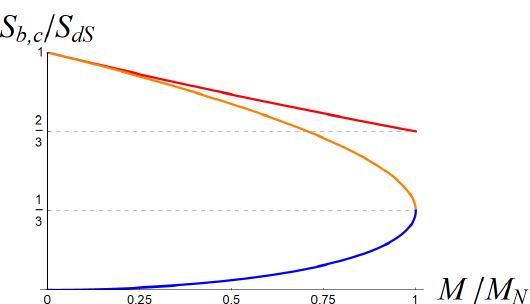
Figure 3: Horizon entropies S M / M , for d = 4. The blue curve corresponds to the black hole entropy S N orange curve shows the cosmological horizon entropy S S is approximately a straight line (red curve), and is always less than (or equal SdS to) S . For the Nariai solution the horizon entropies are both equal to one third of dS the de Sitter entropy, and their sum is the Nariai entropy S appeared in [ 58 ]